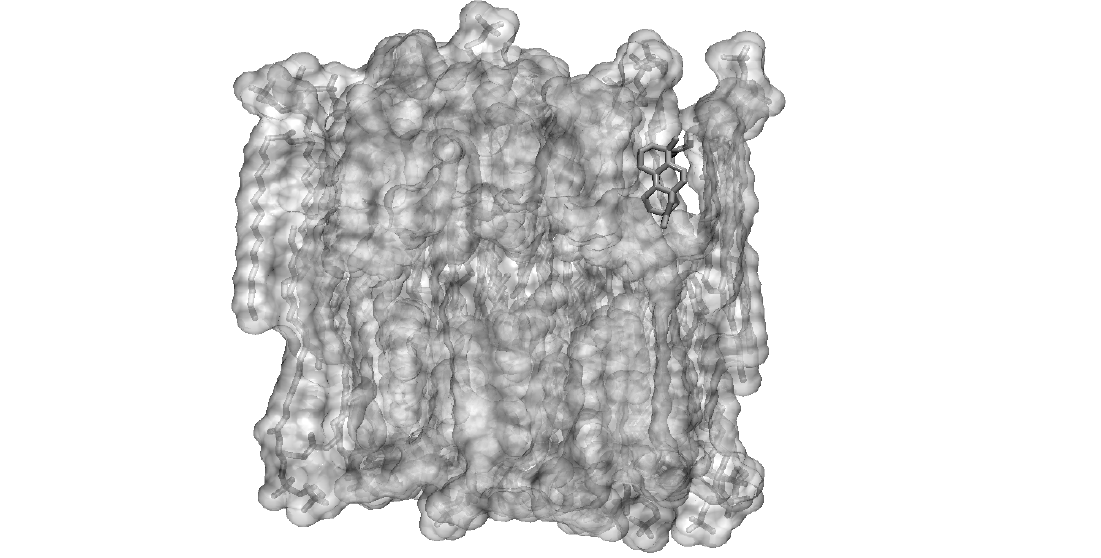
Figure 2. Mode of insertion of one molecule of kaurenoic acid ( 1 ) into a POPC bilayer, showing the hydrogen-bond interaction between the carboxylic group of the diterpenoid and a phosphoryl oxygen atom of the